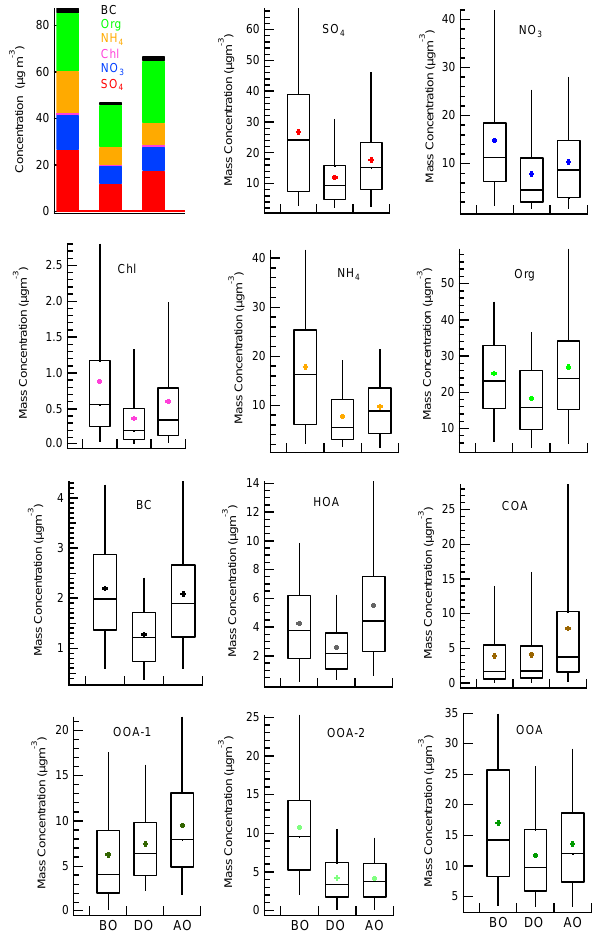
Fig. 6. The comparison of PM 1 compositions before the Olympics (BO, 23 July–7 August), during the Olympics (DO, 8–24 August) and after the Olympics (AO, 25 August–10